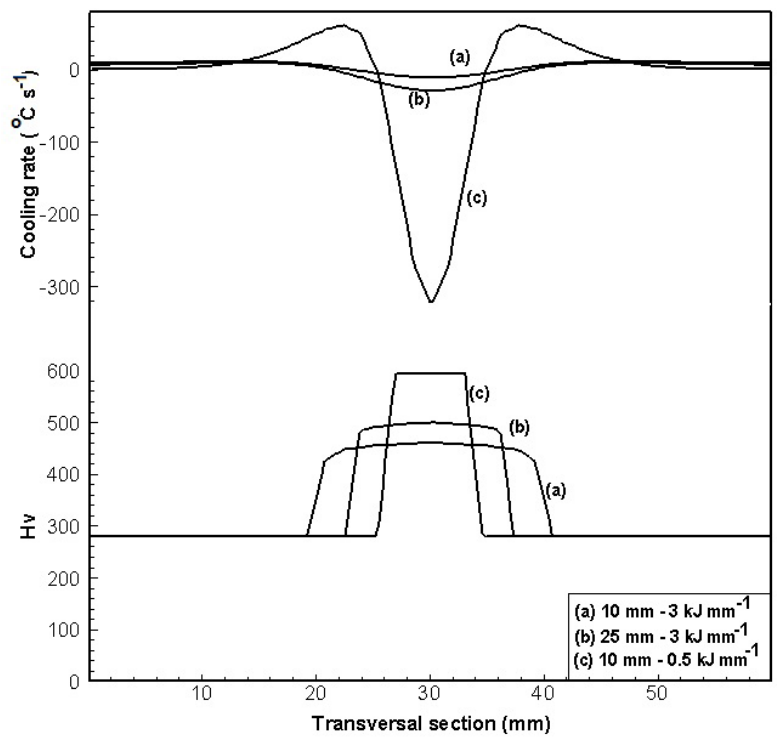
Figure 16 - Cooling rates versus hardness transversal distribution at the